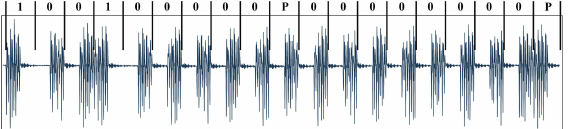
Figure 4. Magnitudes of ATQA corresponding to “04 00” in Manchester